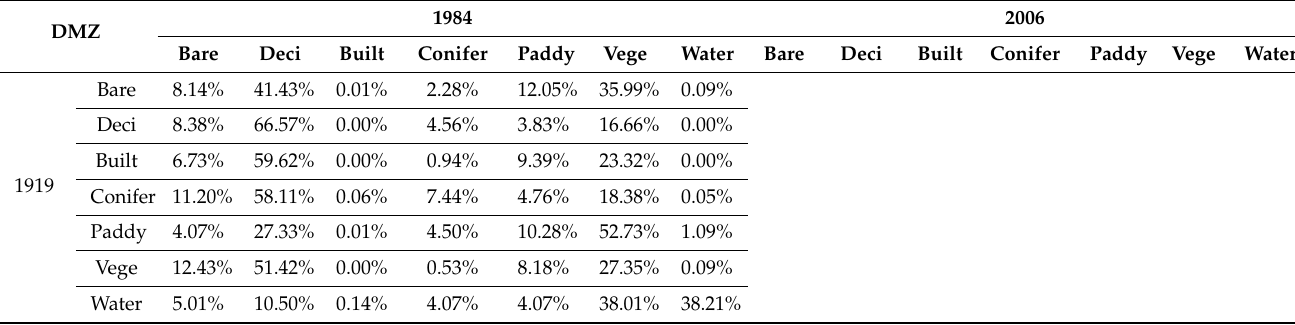
Table A1. Land-use and -cover transition matrix in this study. Deci, deciduous forest; Vege, vegetation; Water, water body and floodplains.